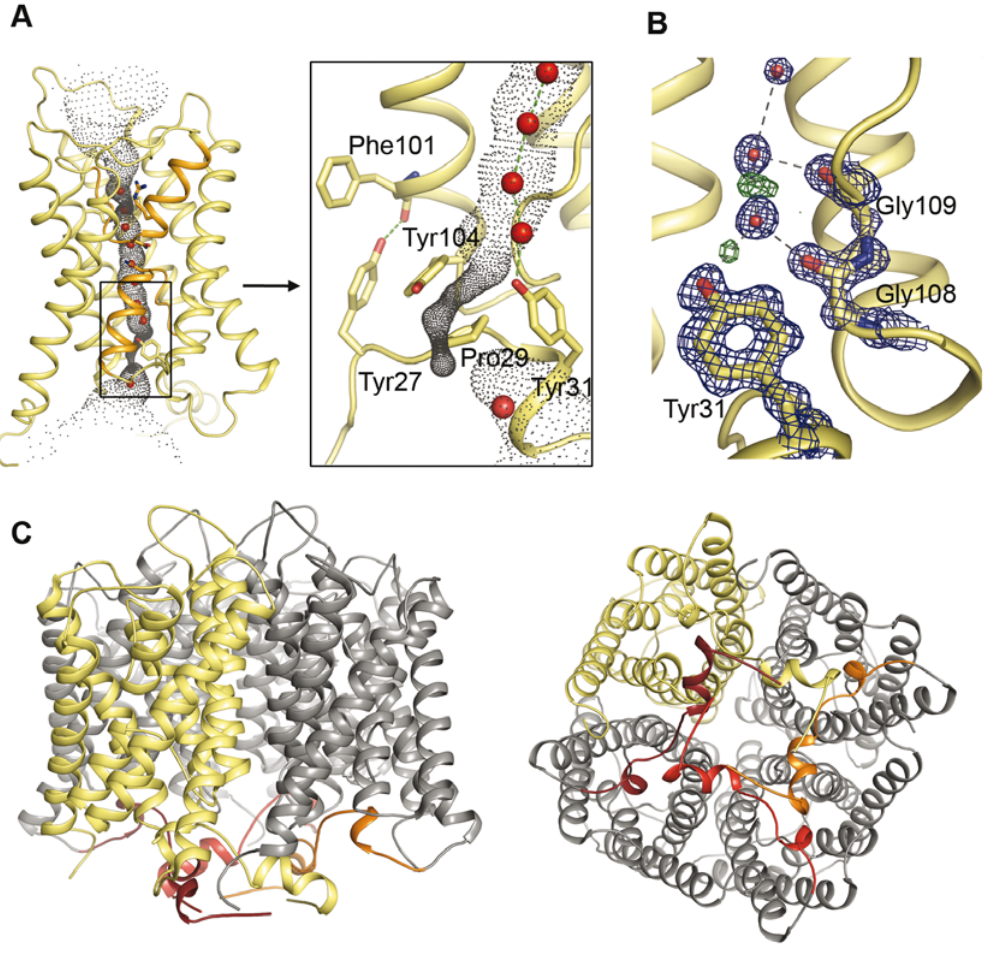
Figure 2. Aqy1 is closed on the cytoplasmic side by the N terminus. (A) A HOLE representation and an inset showing a close up view of the Aqy1 water channel constriction near Tyr31. (B) 2 F obs 2 F calc electron density map (blue, contoured at 2.0 s ) and F obs 2 F calc electron density map (green, contoured at + 2.2 s ) near Tyr31. Residual positive F obs 2 F calc electron density reveals electrons associated with protons participating in hydrogen bond interactions. (C) The N termini from the four subunits of the tetramer twist around each other and form an N-terminal bundle positioned on the cytoplasmic side of the membrane.